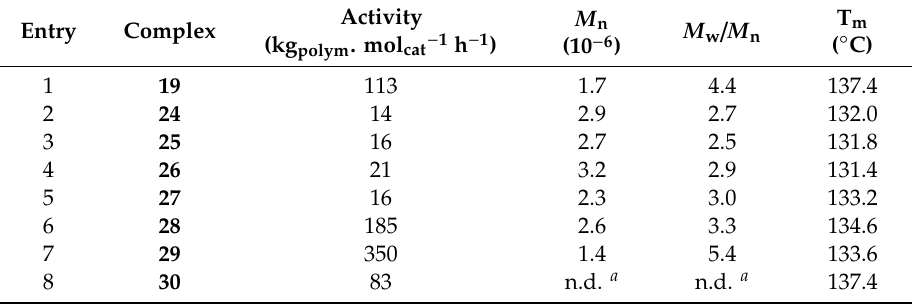
Figure 9. Molecular structures of complexes 25 (left), 26 (center) and 27 (right) [15]. Table 8. Polymerization of ethylene catalysed by 19 - and 24–30 / MAO systems